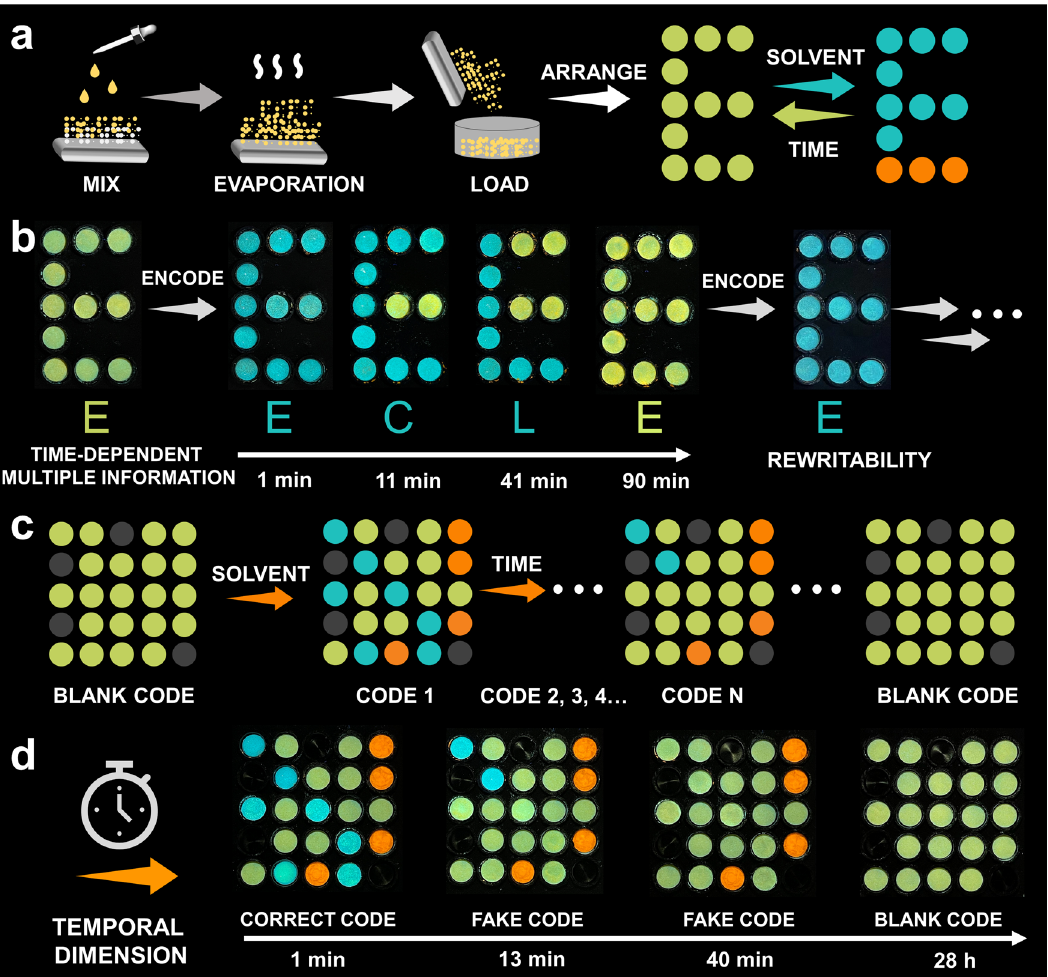
Fig. 7 A visual demonstration of the information encryption material on a time scale. a Schematic representations of the process of fabricating such a material and its dynamic fl uorescence. Yellow dots represent the dry silica gel powder loaded with compound PY16 , which turned blue and orange after adding dichloromethane and water, respectively. b Photographs of the encrypted letter “ E ” before and after treatment with dichloromethane, displaying time-dependent multiple pieces of information in which the correct piece can be identi fi ed only at a speci fi ed time. c Schematic representations and fl uorescence images ( d ) of the dynamic 3D code on a time scale. The blue- and orange-coloured information self-erased into yellow as time passed, leading to the generation of a 4D code with time-dependent